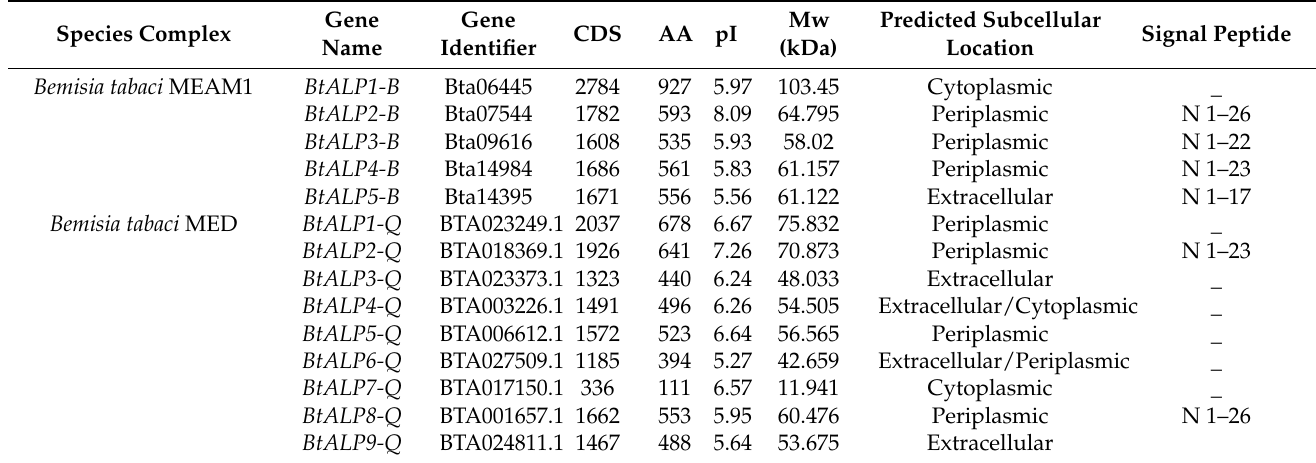
Table 2. Summary of ALP genes found in Bemisia tabaci MEAM1 and